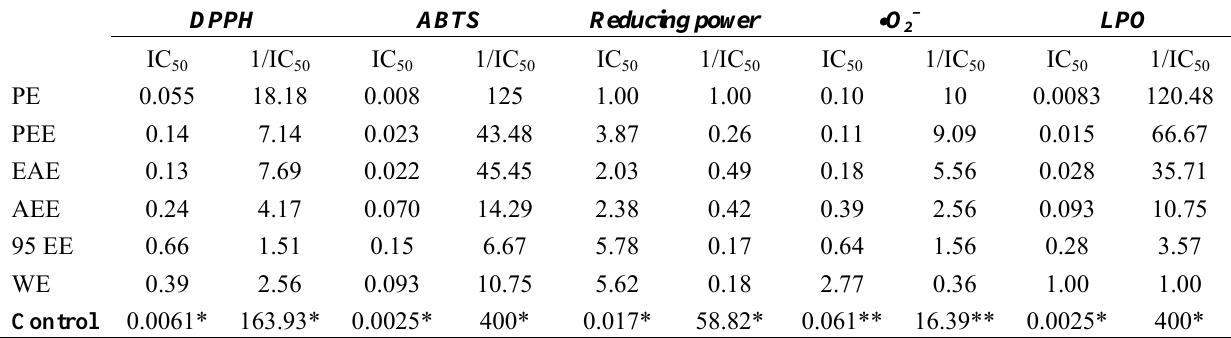
and 1/IC of the extracts of Radix Angelicae 50 50